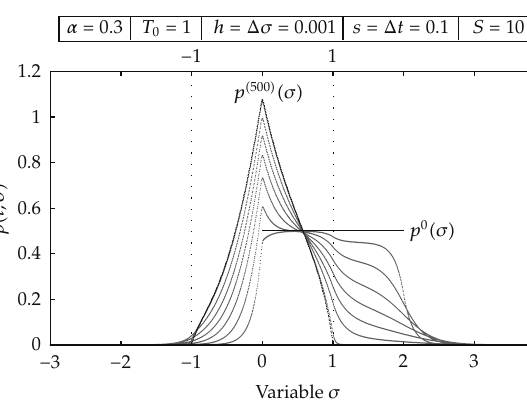
Figure 9: Graphics sequence: Subcase